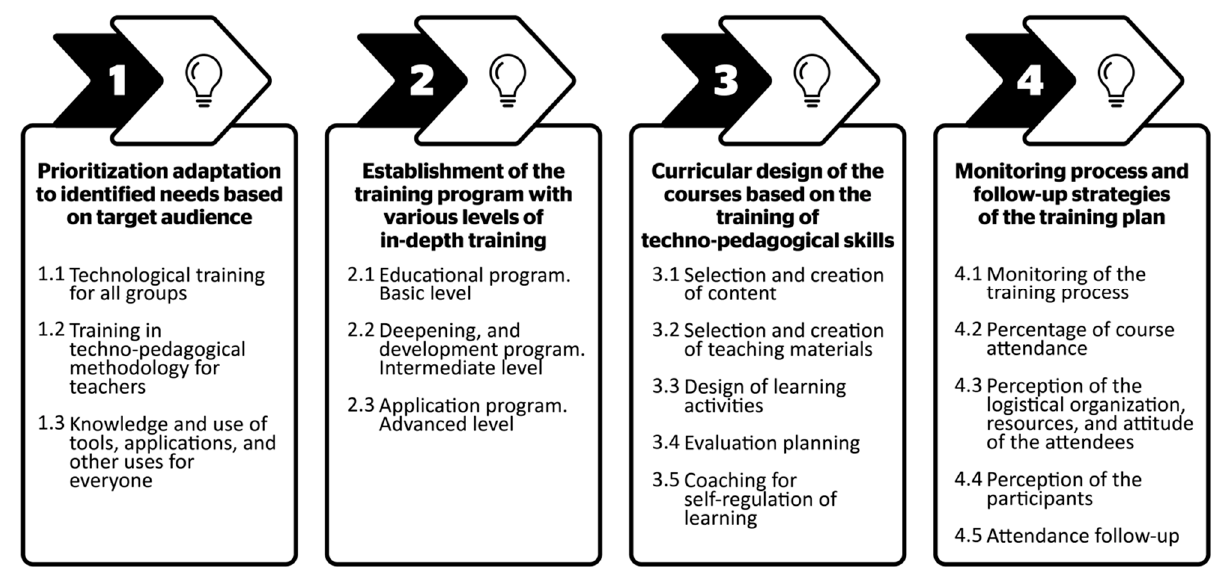
Figure 2. Representative milestones of the emergency training plan. Note. Scheme designed based on the information presented by Martin-Cuadrado et al. Adapted from [10].